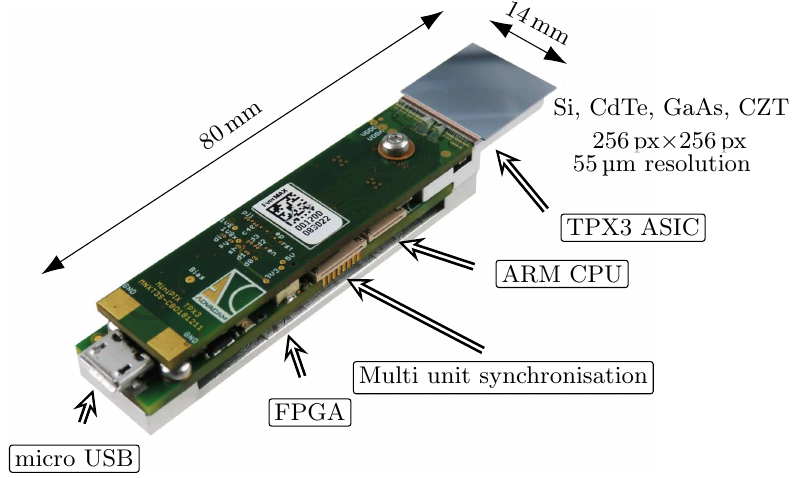
Figure 1. Illustration and description of the MiniPIX Timepix3 detector without a protective